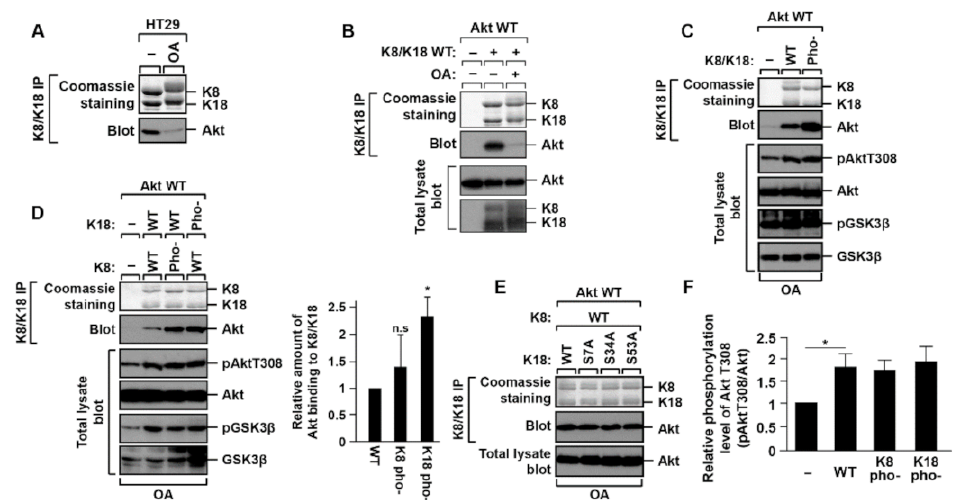
Figure 1. K8/K18–Akt interaction is downregulated by K18 S7/34/53 phosphorylation. ( A ) HT29 cells were treated with okadaic acid (OA, 1 µ M) for 2 h, and then Akt interaction was tested by immunoprecipitation against K8/K18 followed by immunoblotting with Akt antibody. ( B ) BHK- 21 cells were transfected with Akt WT and K8/K18 WT, and treated with OA (0.5 µ M) for 2 h. K8/K18 immunoprecipitates and total lysates were prepared and immunoblotted with the indi- cated antibodies. ( C ) K8/K18 WT or phosphorylation-deficient mutants (pho-) were transfected into BHK-21 cells together with Akt WT, and then OA was treated 2 h before harvesting cells. K8/K18–Akt interaction was tested by coimmunoprecipitation assay, and cell lysates were im- munoblotted with phosphorylated Akt and phosphorylated GSK3 antibodies. K8/K18 pho- indicates K8 S21/22/24/37/43/74/432/451A and K18 S7/34/53A. ( D ) BHK-21 cells were transfected with the indicated keratin constructs together with Akt WT. Immunoprecipitation was performed with the cells after a 2-h treatment of OA. Each keratin construct is represented as follows: K8 pho-, K8 S21/22/24/37/43/74/432/451A; K18 pho-, K18 S7/34/53A. The graph represents the means ± S.E. of three independent experiments. * indicates p < 0.05. ‘n.s.’ indicates ‘not significant’. ( E ) Akt WT and K8 WT were transfected into BHK-21 cells with the K18 single-site phosphorylation-deficient mutant (K18 S7A, K18 S34A, or K18 S53A). The cells were treated with OA for 2 h, and the Akt inter- action with K8/K18 was tested by the immunoprecipitation assay. ( F ) The transfected BHK-21 cells were prepared as described in panel D. Akt activity was determined by immunoblotting cell lysates with antibody against phosphorylated Akt T308. The data were obtained from three independent experiments, and the mean values ± S.E. are shown in the graph. * indicates p <